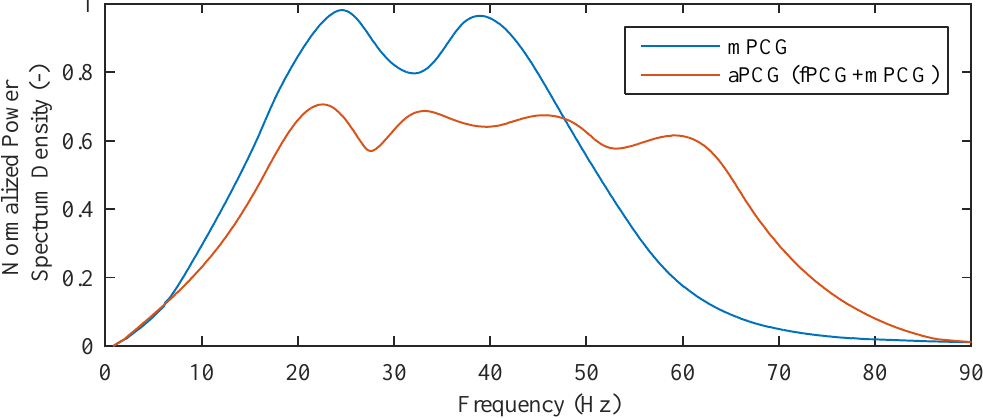
Figure 4. Normalized Power Spectrum Density of data acquired from the test